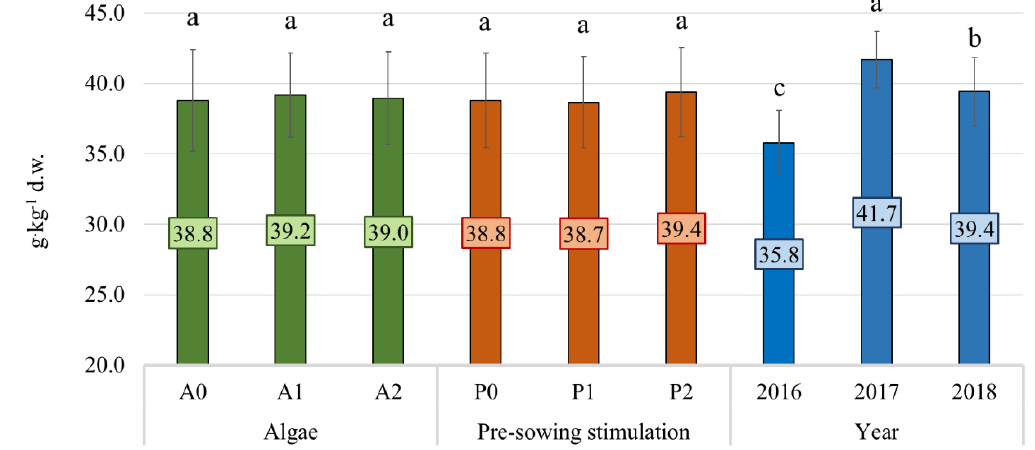
Figure 4. The mean crude fat content of protein in oat grains in 2016–2018, depending on the experimental factors used. According to Tukey’s HSD test, means marked with the same letter are not significantly different at α ≤ 0.05.